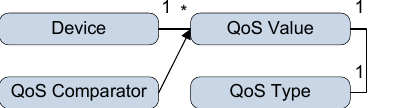
Figure 4. Definition of the quality of service linked to a specific